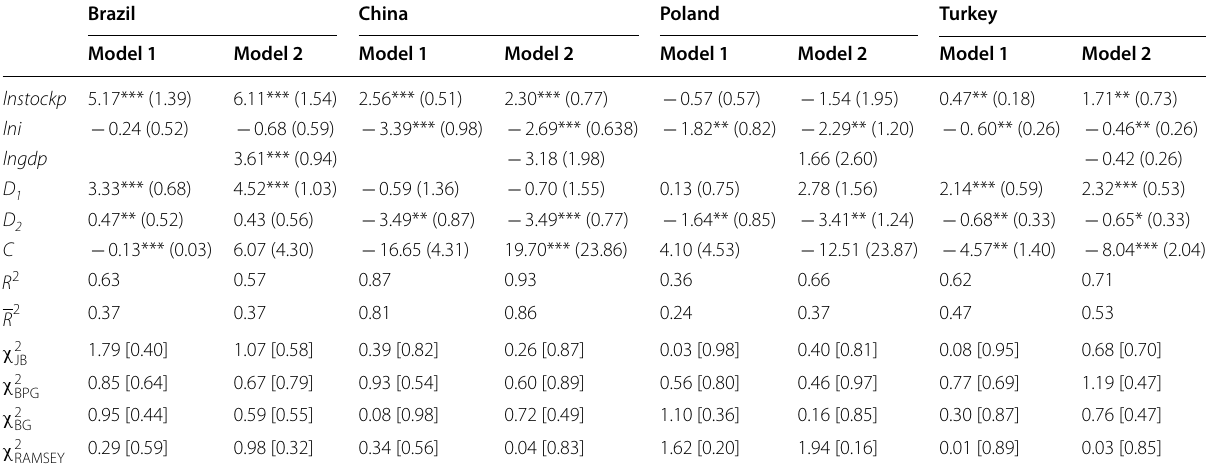
*, **, *** indicate statistical significant at 10%, 5% and 1%, respectively. (..) shows the standard errors and [..] presents probability value